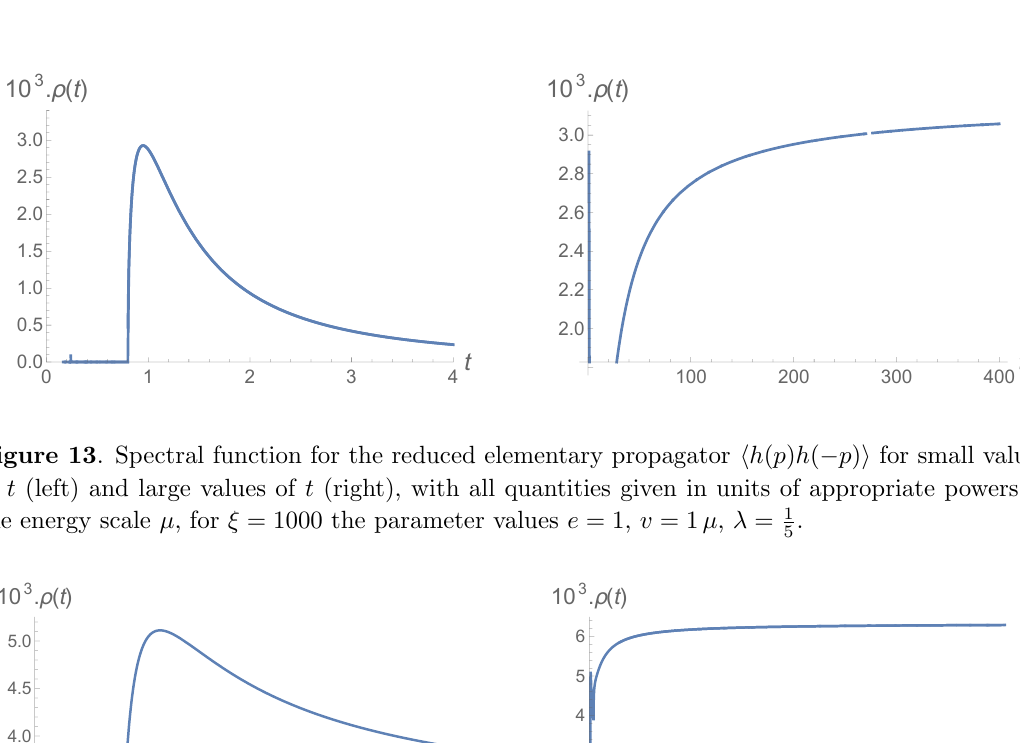
Figure 14 . Spectral function for the reduced composite propagator h O ( p ) O ( (cid:0) p ) i for small values of t (left) and large values of t (right), with all quantities given in units of appropriate powers of the energy scale (cid:22) , for the parameter values e = 1, v = 1 (cid:22) , (cid:21) = 1 . 5 (cid:15) the pole masses of h V 0 ( x ) V 0 ( y ) i T and h O ( x ) O ( y ) i are exactly the same as (cid:22) (cid:23)